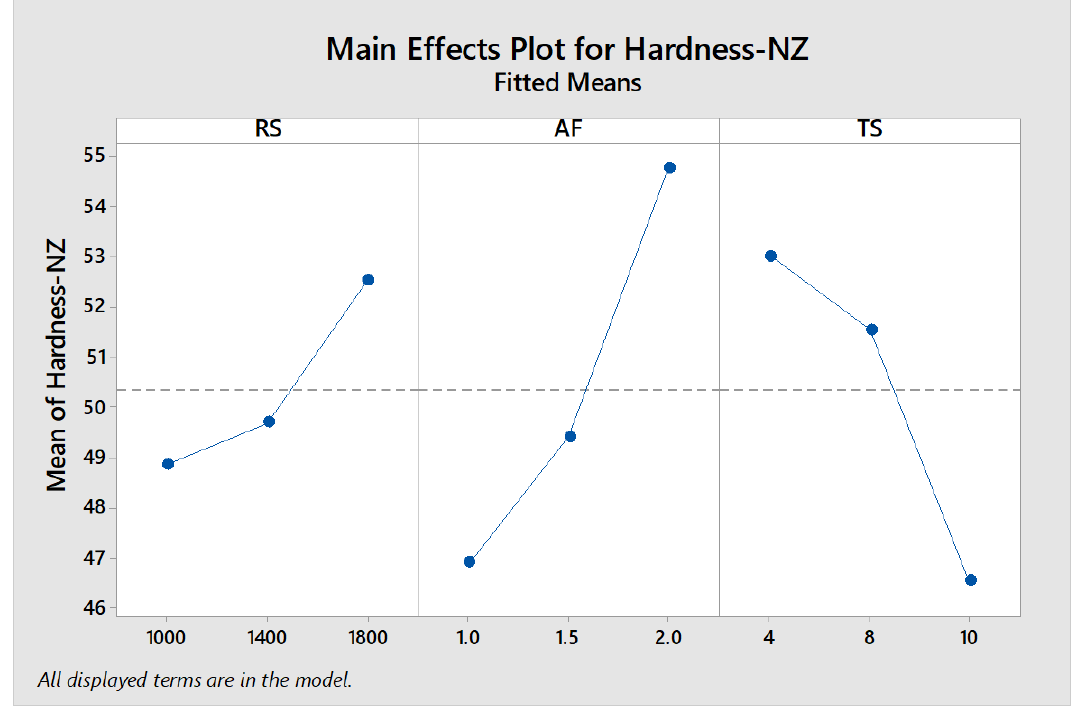
Figure 20. Main effects plot — hardness in NZ.